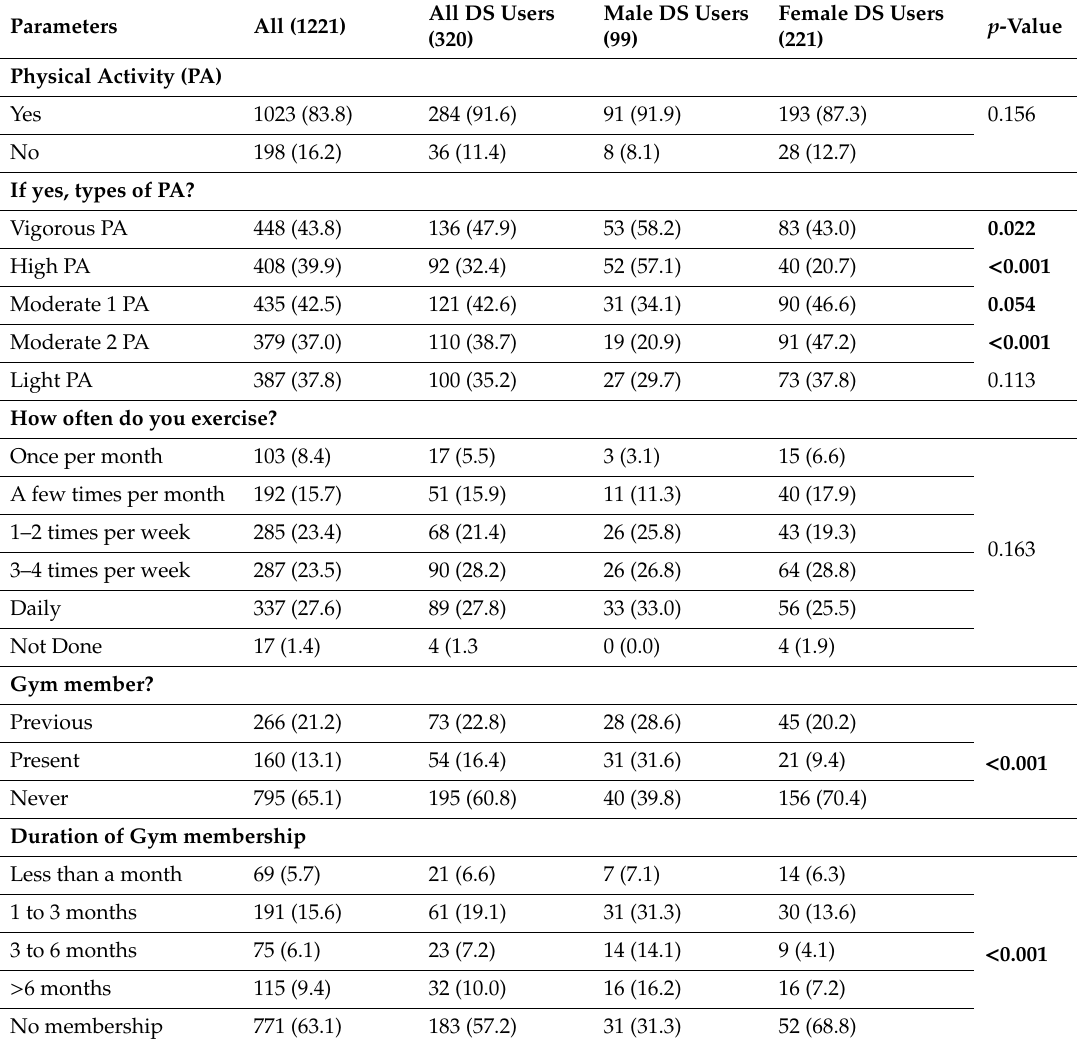
Table 3. Relationship between physical activity and dietary supplement use among